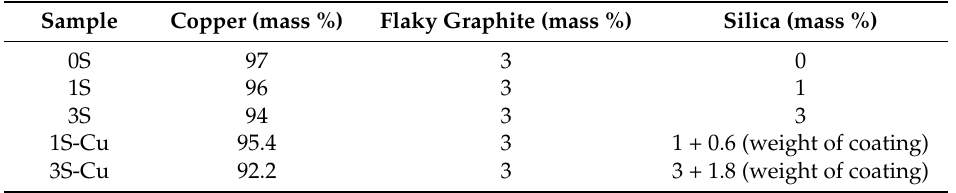
Table 2. Composition of the composites.